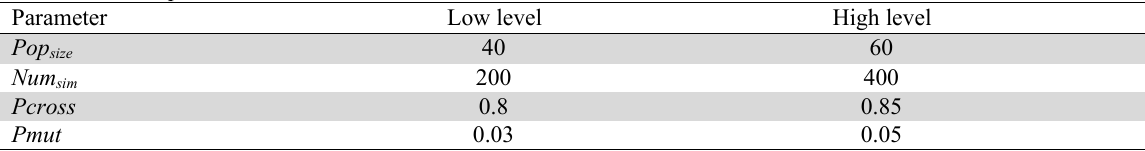
The levels of GA parameters